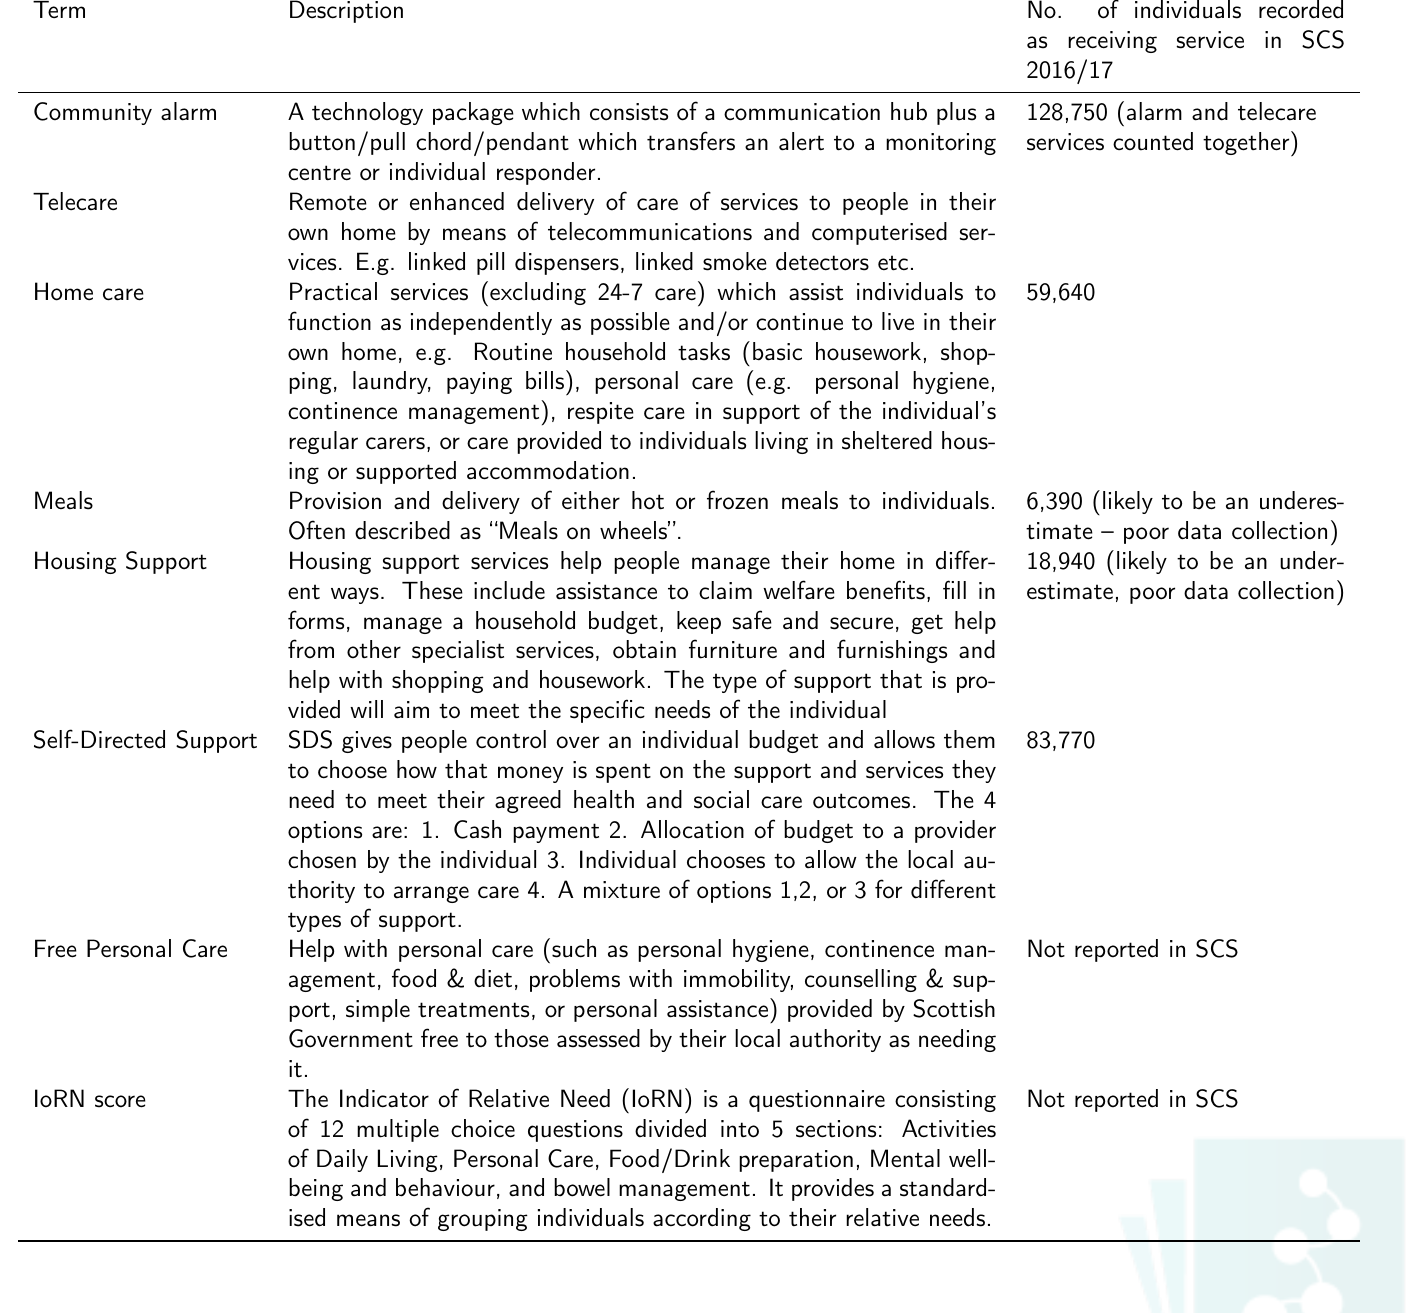
Table 1: Key terms relating to